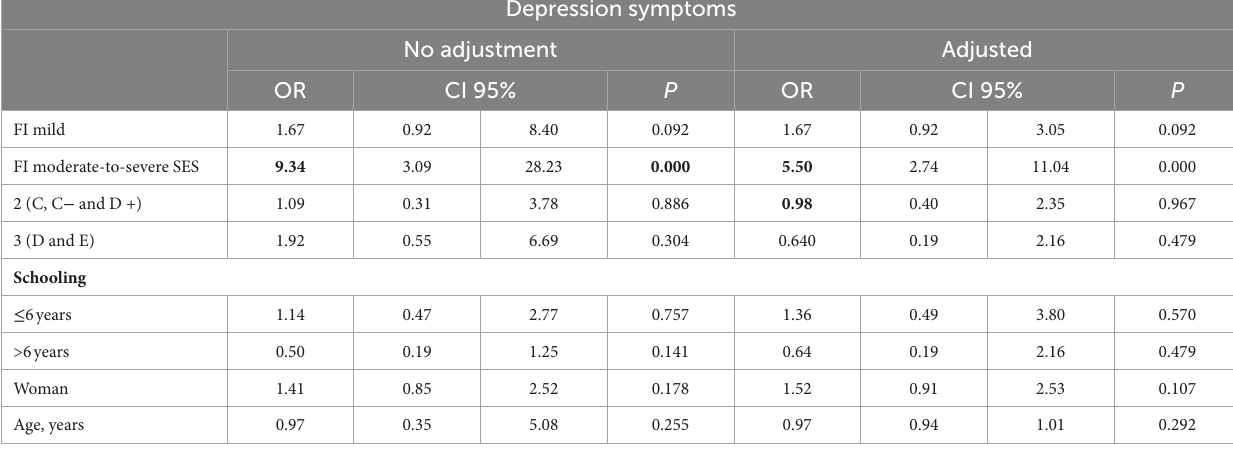
TABLE 3 Logistic regression on the association between food insecurity and depression